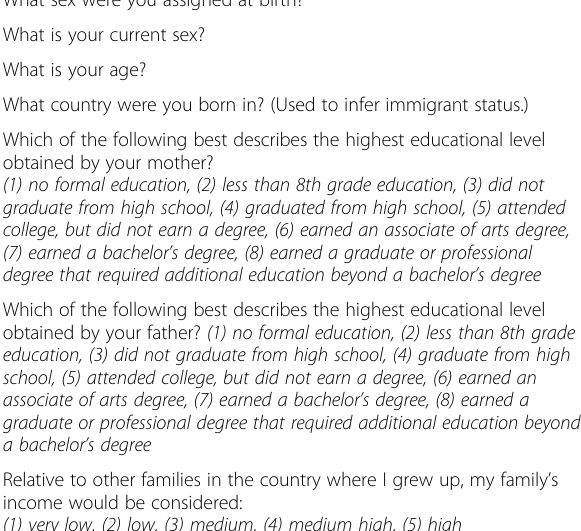
Table 3 Background